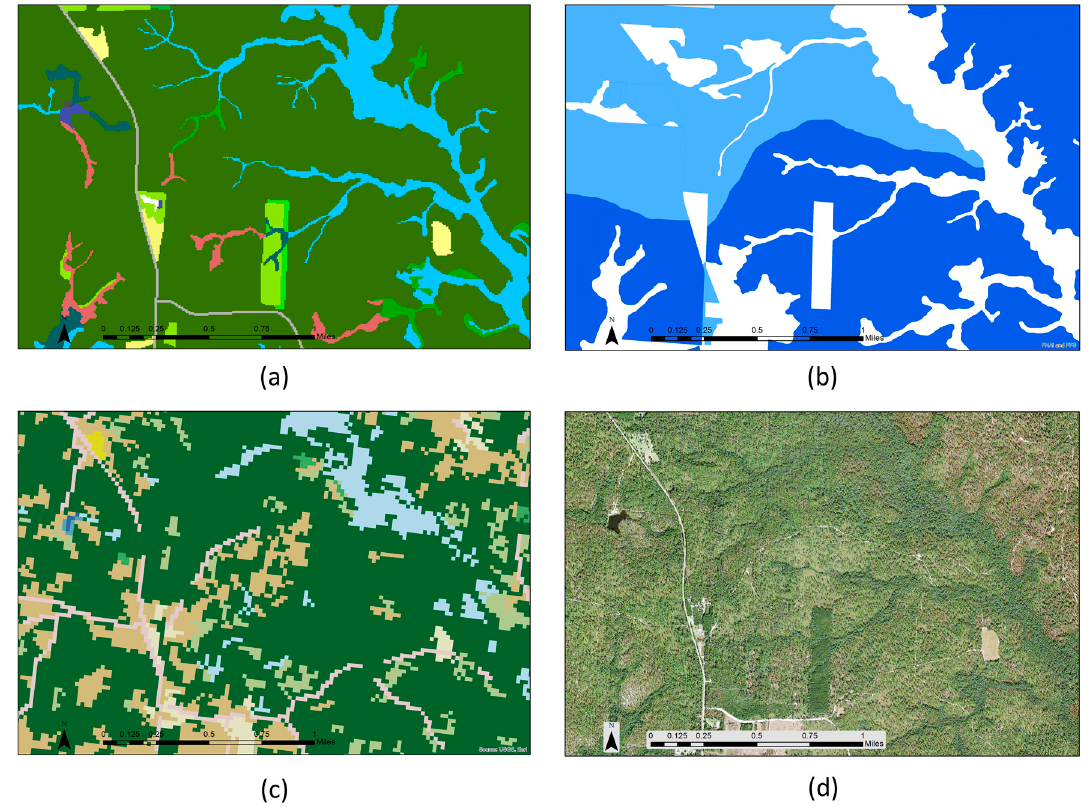
Figure 2. Sample images from available public land cover classification products in our study area: ( a ) Cooperative Land Cover dataset from Florida Natural Areas Inventory; ( b ) Condition Class for Maintenance of Longleaf dataset from Florida Natural Areas Inventory; ( c ) National Land Cover Dataset (2011); and ( d ) National Agricultural Imagery Program (2013), which is the imagery used in this study for probabilistic classification.